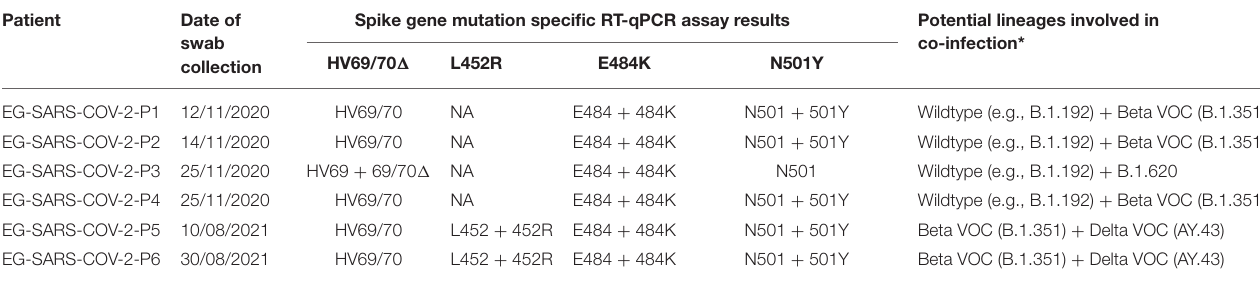
TABLE 1 | SARS-CoV-2 co-infections identified in Equatorial Guinea.